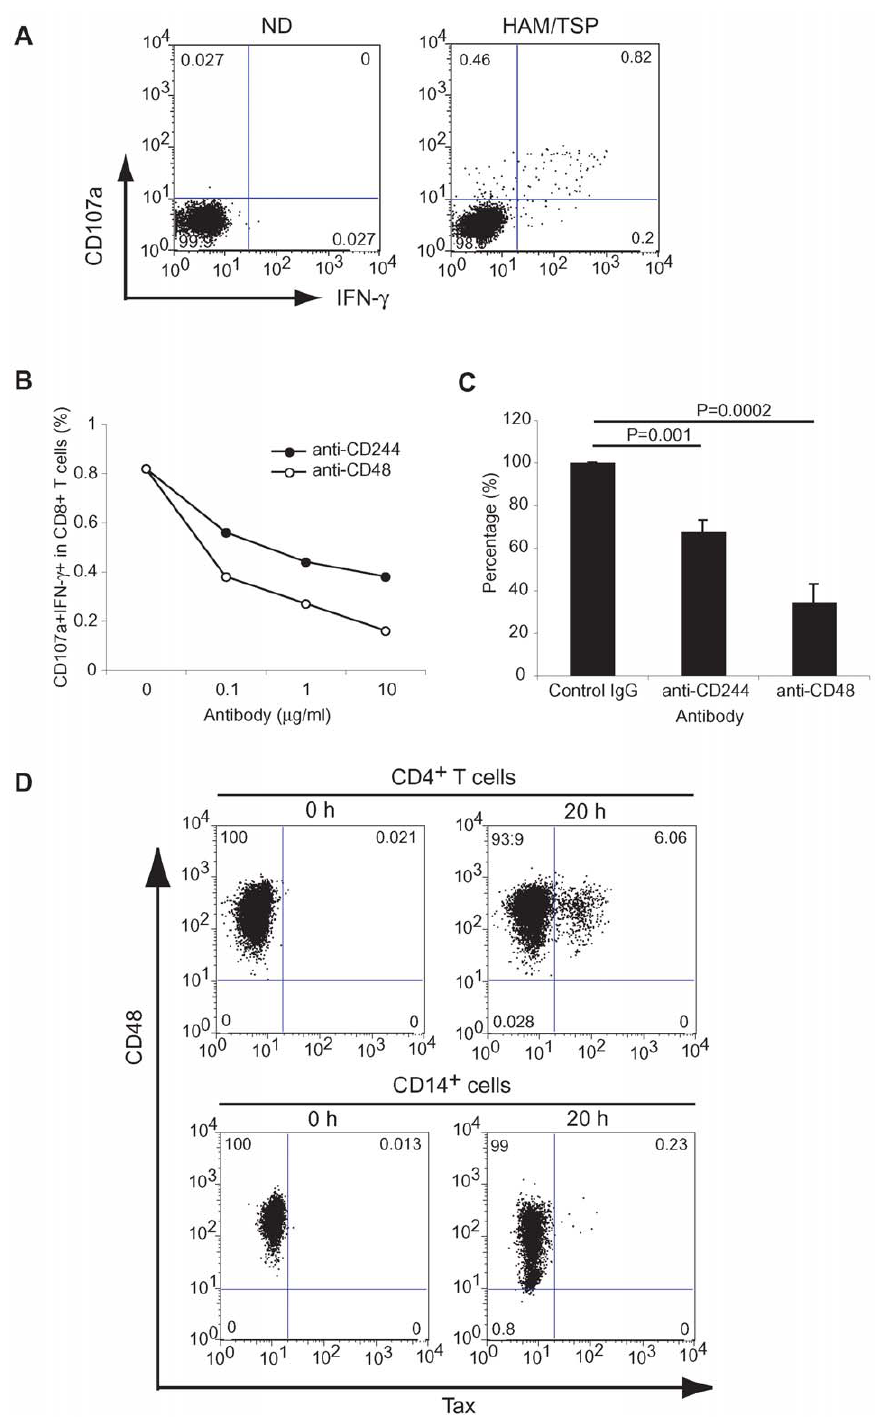
Figure 2. Involvement of CD244 in CD8 + T cell degranulation and IFN- c expression of patients with HAM/TSP. (A) Representative dot plot of spontaneous degranulation and IFN- c expression in CD8 + T cells of a ND and a patient with HAM/TSP after culture for 24 hours. The PBMCs were cultured for 24 hours without any exogenous stimulators. (B) Dose-dependent inhibition of spontaneous degranulation and IFN- c expression in CD8 + T cells of a patient with HAM/TSP by anti-CD244 (closed circle) and anti-CD48 (opened circle). The PBMCs were cultured with each antibody for 24 hours. (C) Inhibitory effects of anti-CD244 and anti-CD48 on degranulation and IFN- c production in CD8 + T cells of patients with HAM/TSP. The PBMCs were cultured with 1 m g/ml of control IgG, anti-CD244 or anti-CD48 for 24 hours. The amount of CD107a/IFN- c expressions of CD8 + T cells cultured with control IgG were normalized to 100%, and then, those in PBMCs cultured with each antibody were calculated. The graph was prepared from data obtained from 7 patients with HAM/TSP. Error bars represent SD. (D) CD48 and Tax expression in HTLV-I-infected cells of a patient with HAM/TSP. The top panels show CD48 and Tax expression in CD4 + T cells before (left) and after (right) the culture for 20 hours. The bottom panels show CD48 and Tax expression in CD14 + cells before (left) and after (right) the culture for 20 hours.